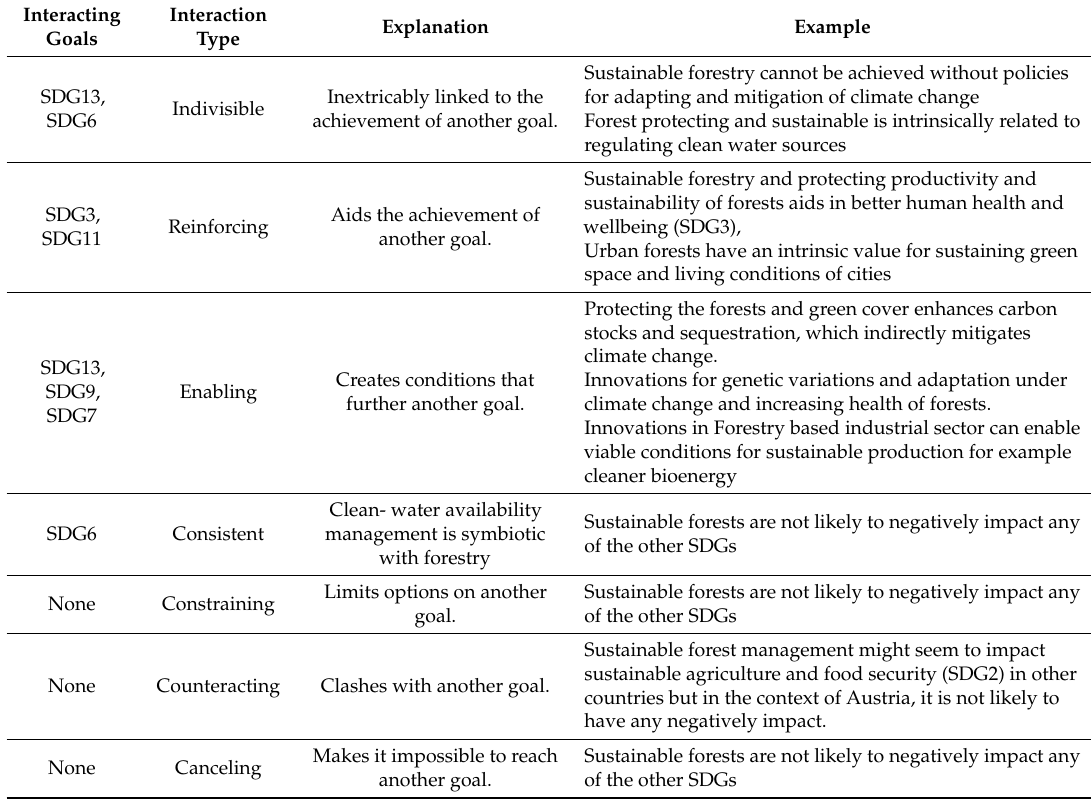
Table 3. The interaction of SDG15 with other SDGs modified from Nisson et al. (2016) [58]. Interacting